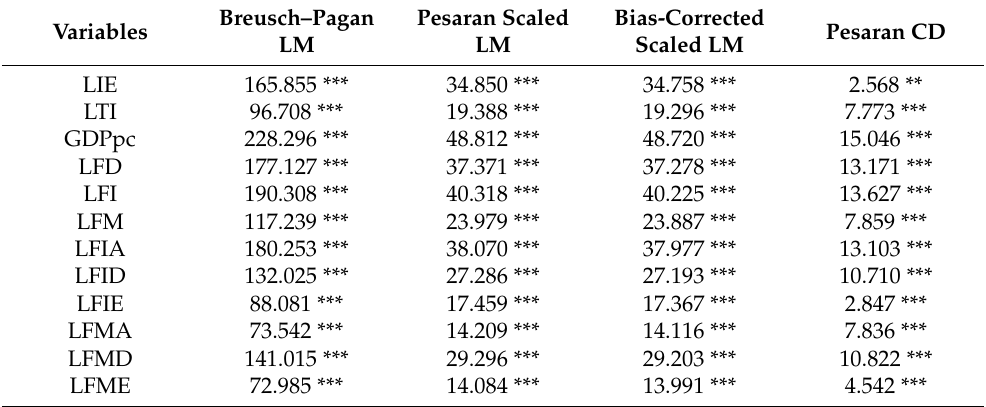
Table 2. Cross-sectional dependence